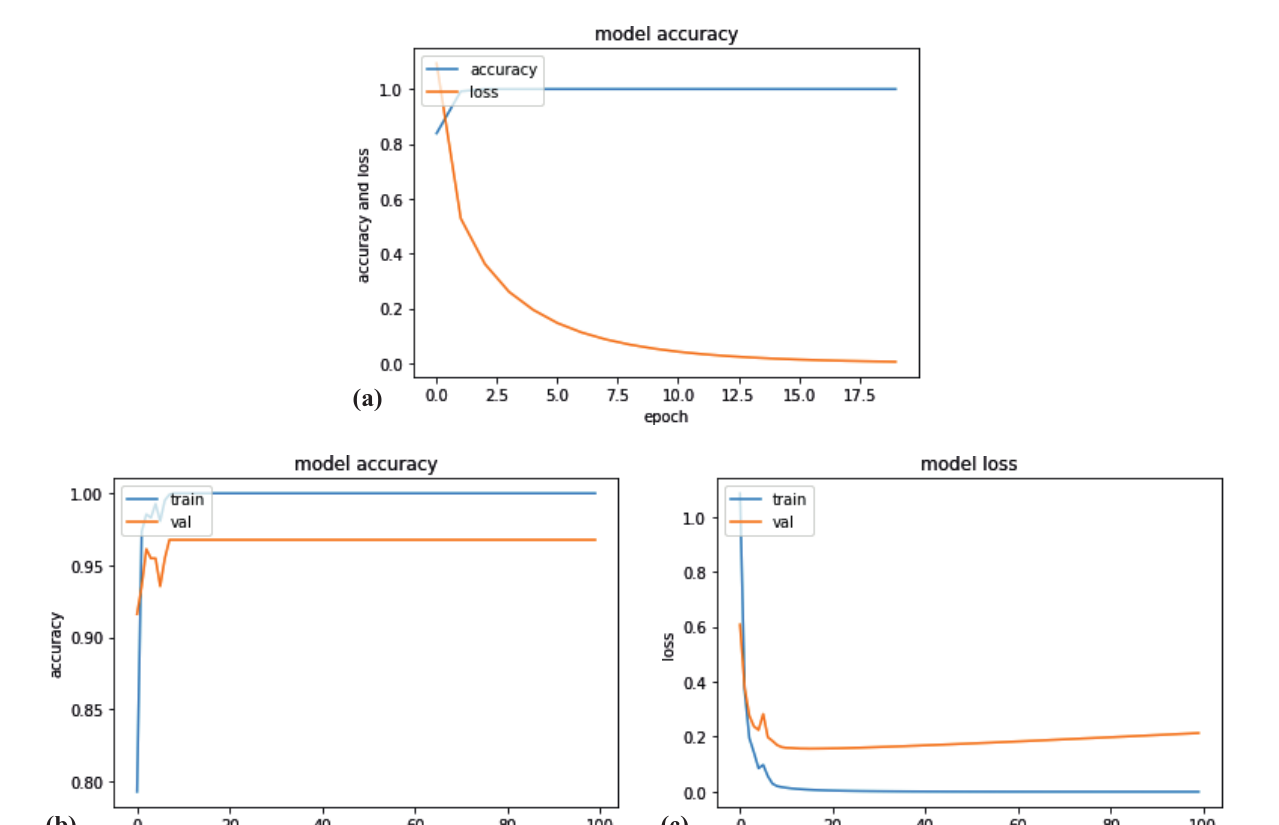
Figure 4. ROC plots for ( a ) Case I and ( b ) Case II, Model 1, Nadam optimizer. The dataset for both plots is Mona Lisa, all channels, α frequency. Class [1–10] for ( a ) and [0–9] for ( b ) corresponds to intensity is equal to [0.1–1.0], respectively.